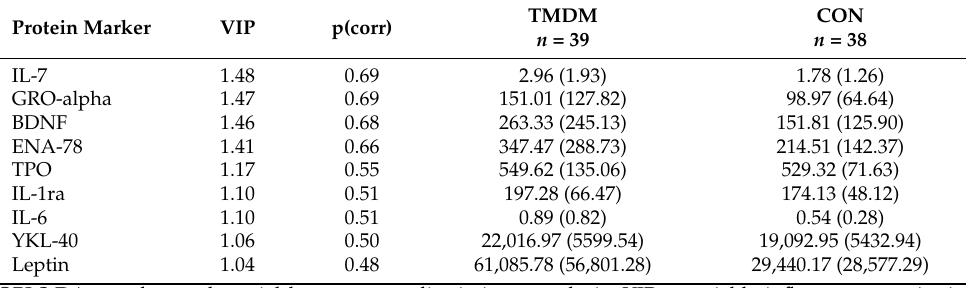
OPLS-DA = orthogonal partial least squares discriminant analysis, VIP = variable influence on projection,